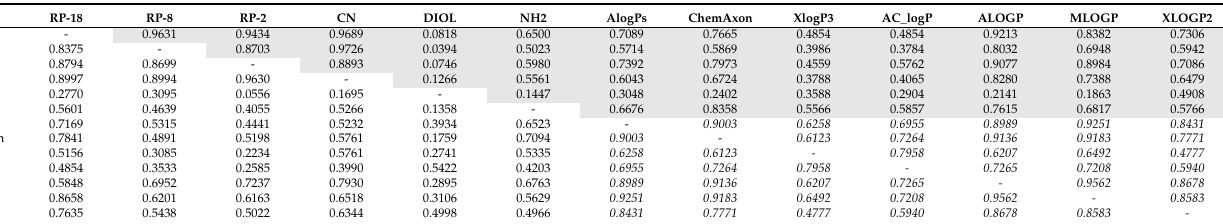
Table 3. The correlation coefficients (r) obtained for the linear correlation between experimental R M0 values calculated according to equations: R M0(1) = b + a R M0(2) in methanol/water system (white area) and in acetone/water system (grey area); R M0 = b + a logP calc in methanol/water system (white area) and in acetone/water system (grey area); as well as logP calc(1) = b + a logP calc(2) (italic) ,